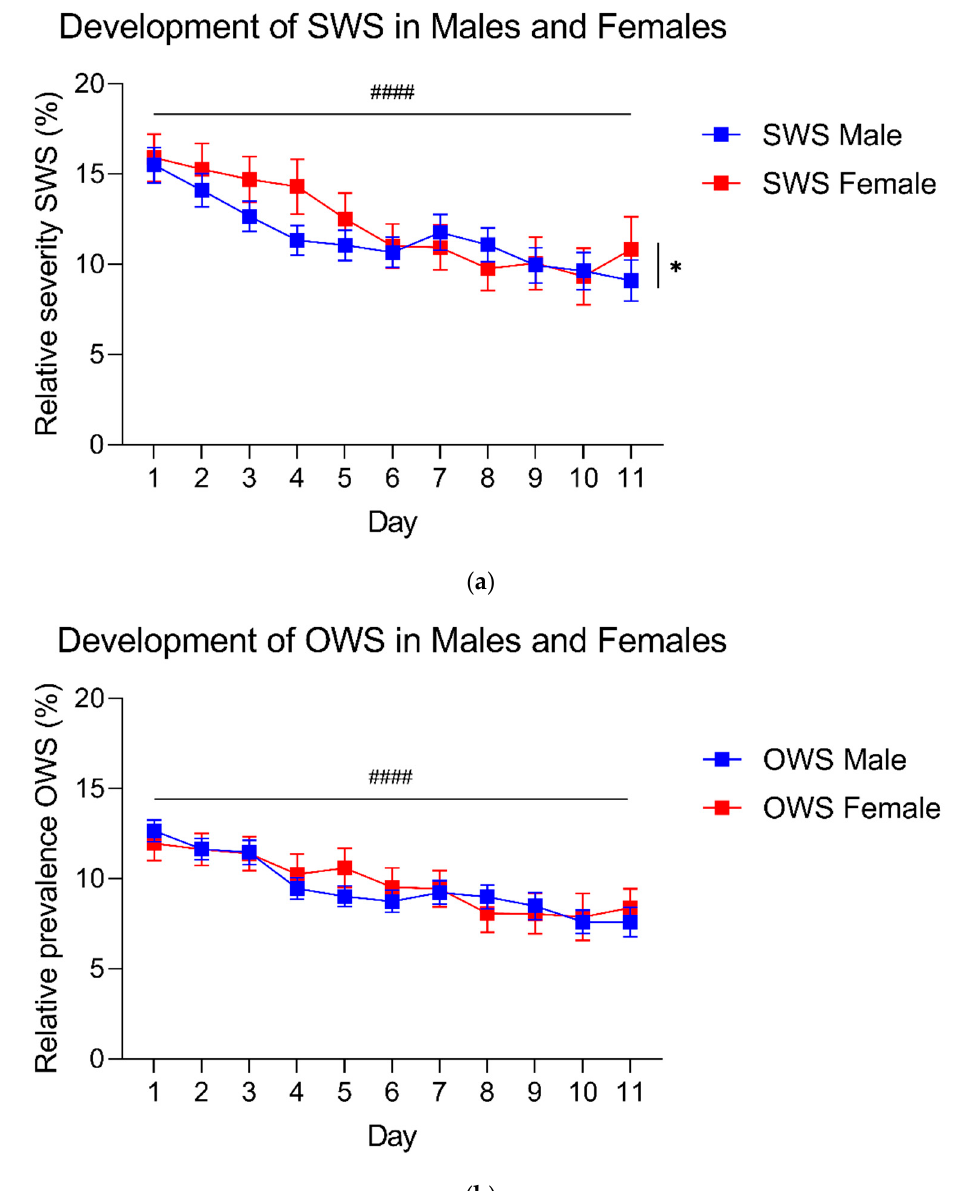
Figure 4. Development of subjective- and objective withdrawal symptoms over time in males and females. ( a ) Development of subjective withdrawal symptoms (SWS) during GHB detoxification, divided by sex. SWS are presented as the average severity of all 33 measured SWS during the day (males n = 74–184, females n = 31–76). ( b ) Development of objective withdrawal symptoms (OWS) during GHB detoxification, divided by sex. OWS are presented as the average presence of all 34 measured objective withdrawal symptoms during the day (males n = 77–191, females n = 31–72). Data are presented as mean ± SEM. #### = main effect of time p < 0.0001; * = time x sex interaction p < 0.05.